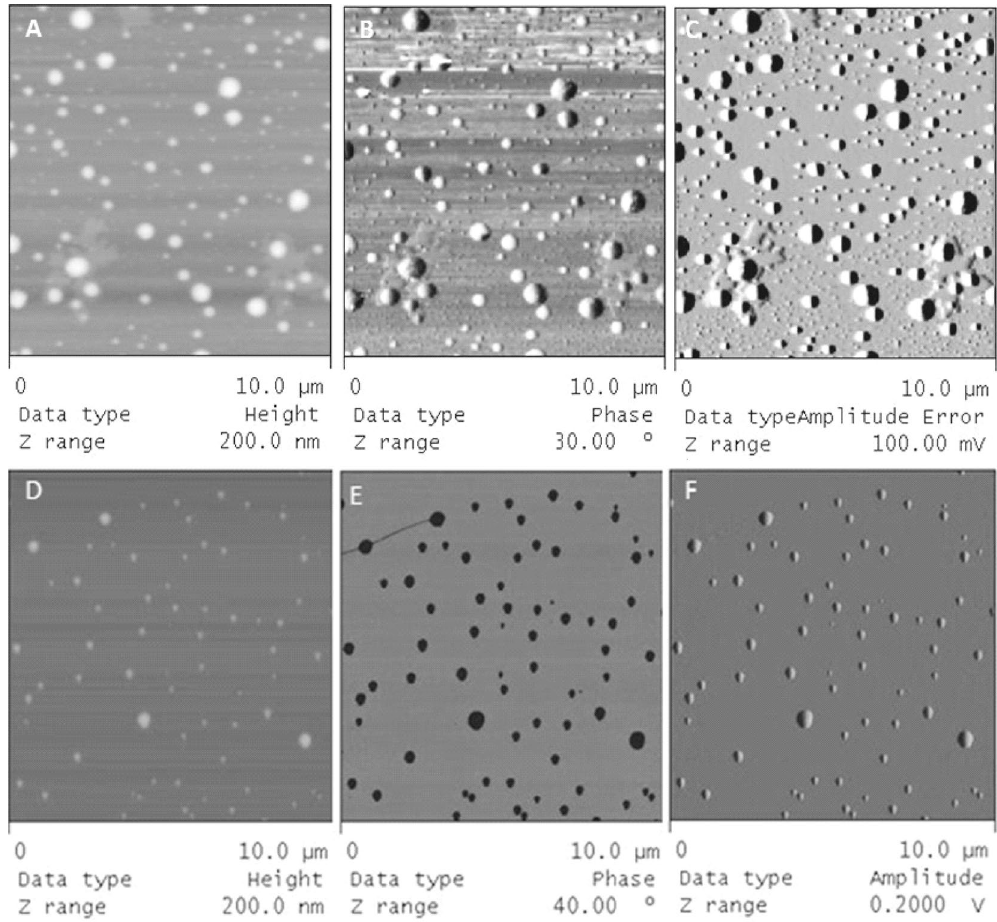
Figure 2. Atomic force microscopy images of lychnopholide nanocapsules obtained in tapping mode (10 × 10 µ m scan size). LYC-PCL NC (top three images) and LYC-PLA-PEG NC (bottom three images) showing spherical nanostructures. Height ( A and D ), phase ( B and E ) and amplitude ( C and F ) images are